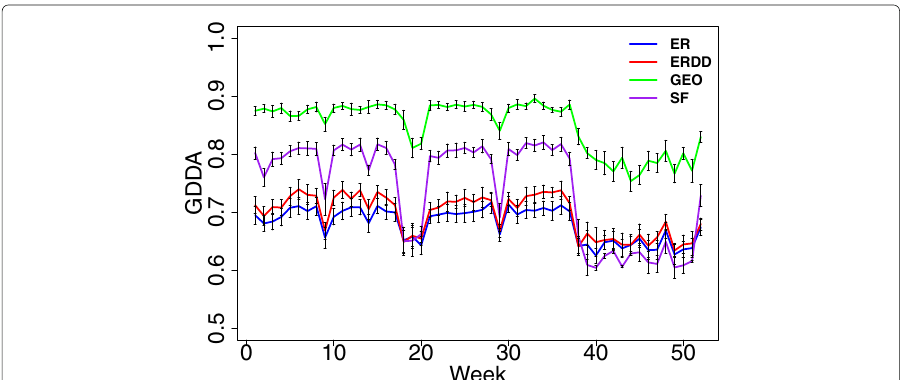
Fig. 4 The fit of four network models (ER, ERDD, GEO, and SF) to each network snapshot with respect to GDDA. For each model, each data network snapshot is compared to 30 random network instances, and the fit is averaged over the 30 instances. Error bars correspond to the standard deviations. The higher the value of GDDA, the better the fit